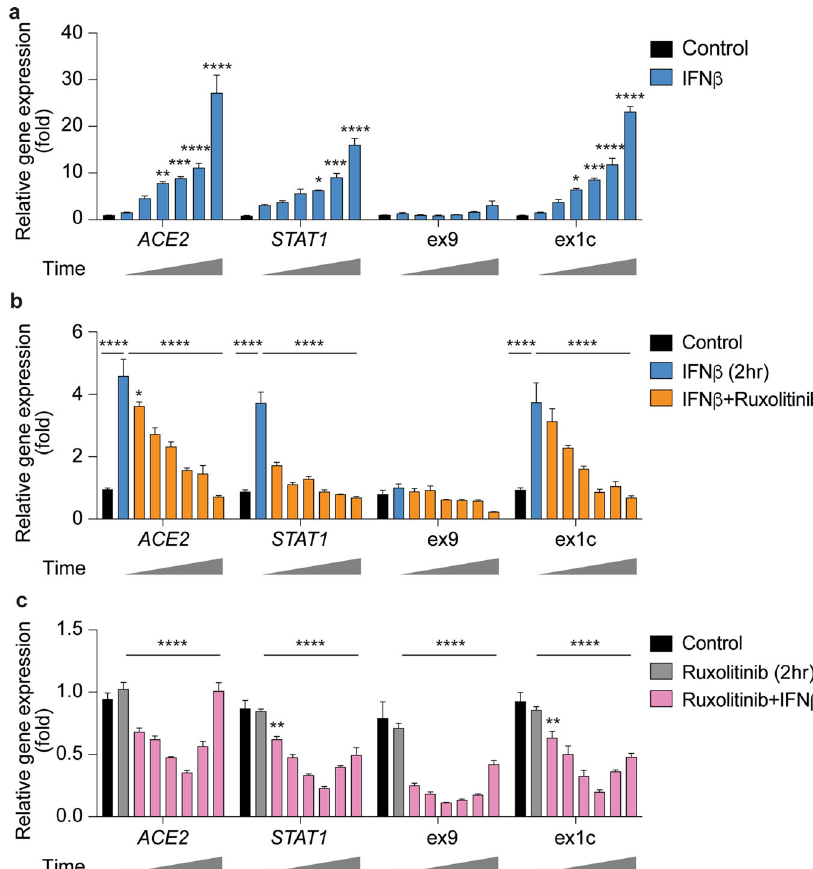
Fig. 6 JAK inhibitor ruxolitinib suppresses IFN β -stimulation. a SAECs were stimulated with IFN β for 12 h (0, 1, 2, 4, 6, 8, and 12 h) and analyzed by qRT- PCR. b SAECs were cultured for two hours in the presence of IFN β followed by the addition of ruxolitinib and qRT-PCR after 0 – 12 h (0, 1, 2, 4, 6, 8, and 12 h). c SAECs were pretreated with ruxolitinib for two hours before stimulating the cells with IFN β , followed by qRT-PCR for 0 – 12 h (0, 1, 2, 4, 6, 8, and 12 h). qRT-PCR results were normalized to GAPDH levels and are shown as the means ± s.e.m. of independent biological replicates (all conditions, n = 4). Two- way ANOVA with followed by Tukey ’ s multiple comparisons test was used to evaluate the statistical signi fi cance of differences between control and cytokine/Jak inhibitor-treated